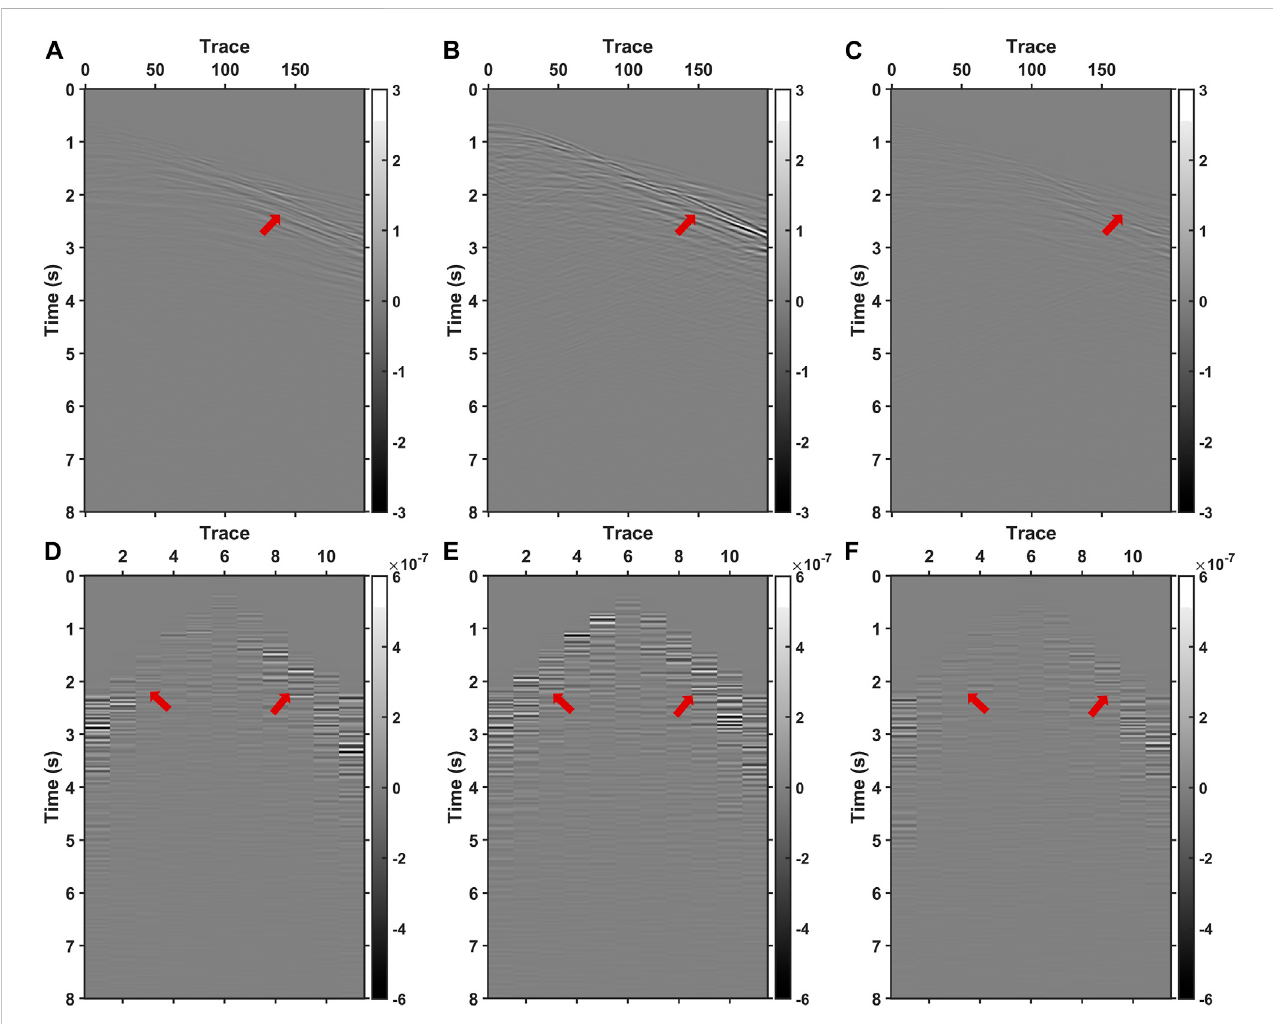
Pressure residuals of FWI results for (A) towed streamer data, (B) OBS data and (C) J-AEFWI. The z -components residuals of FWI results for (D) towed streamer data, (E) OBS data and (F) J-AEFWI.